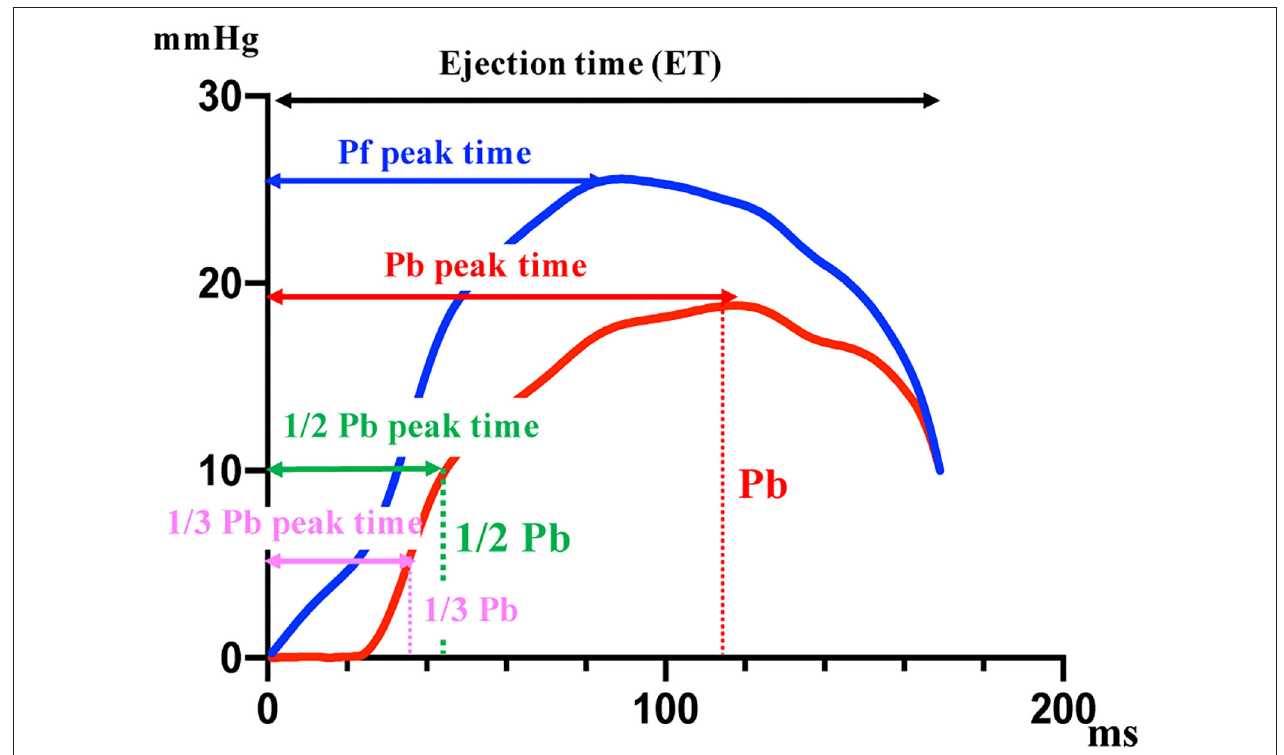
FIGURE 3 | The variables of time phase in PAWR. The variables shown in this figure are associated with the difference between the PH other class and PH thrombosis/heartworm disease class. Pf, forward pressure; Pb, backward pressure. This figure shows the variables of time phase in PAWR of patient with thrombosis in the pulmonary